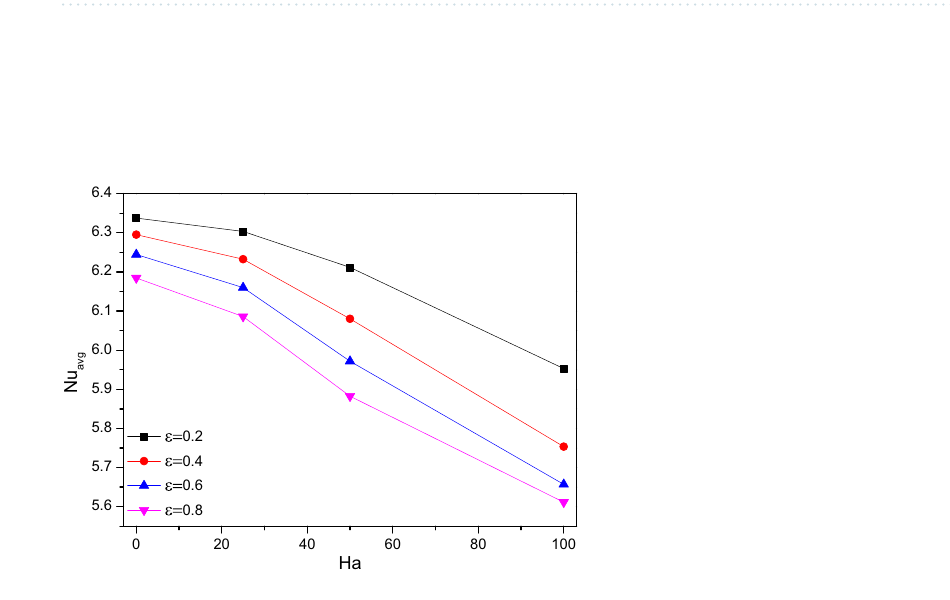
Figure 12. Variations of Nu avg with Ha for diverse ε when Ra = 10 6 , ω = 0 , φ = 0.02 , N = 4 , r = 0.1 and Da = 0.01